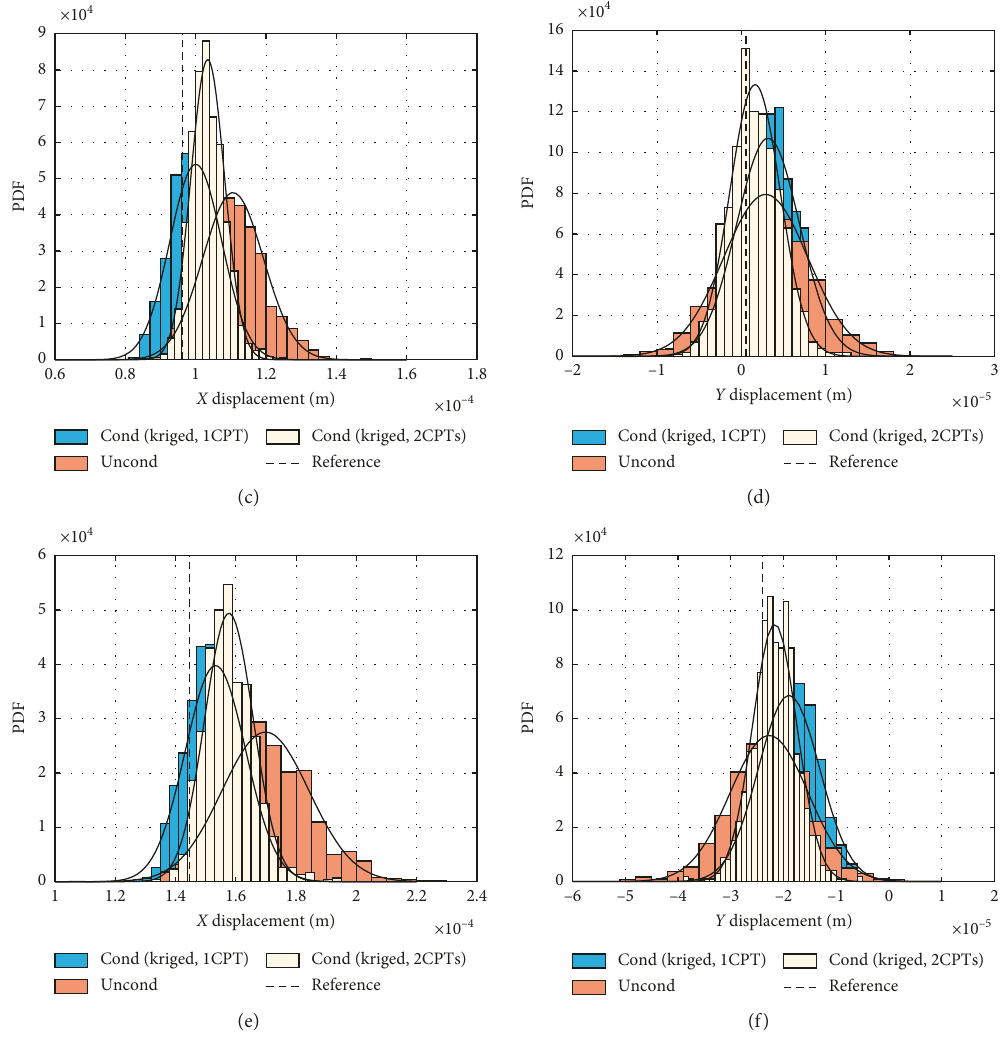
Figure 7: PDF of target point displacements in excavation steps 1–3: comparison between unconditional simulation and conditional simulation based on 1 CPTmeasurement and 2 CPTmeasurements. (a) First layer excavation ( X ), (b) first layer excavation ( Y ), (c) second layer excavation ( X ), (d) second layer excavation ( Y ), (e) third layer excavation ( X ), and (f) third layer excavation ( Y